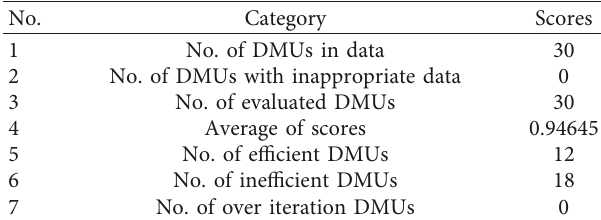
Table 9: Basic situation of data